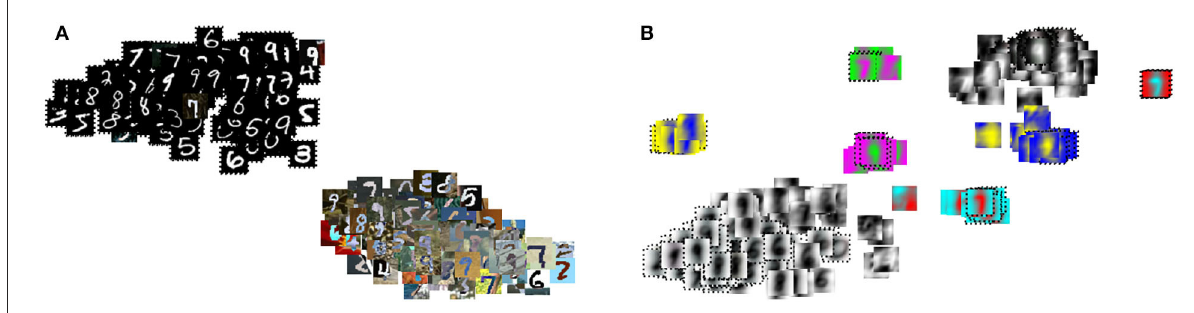
FIGURE10 The t-SNE result of Figure 9 with the input images shown (A) before and (B) after the proposed